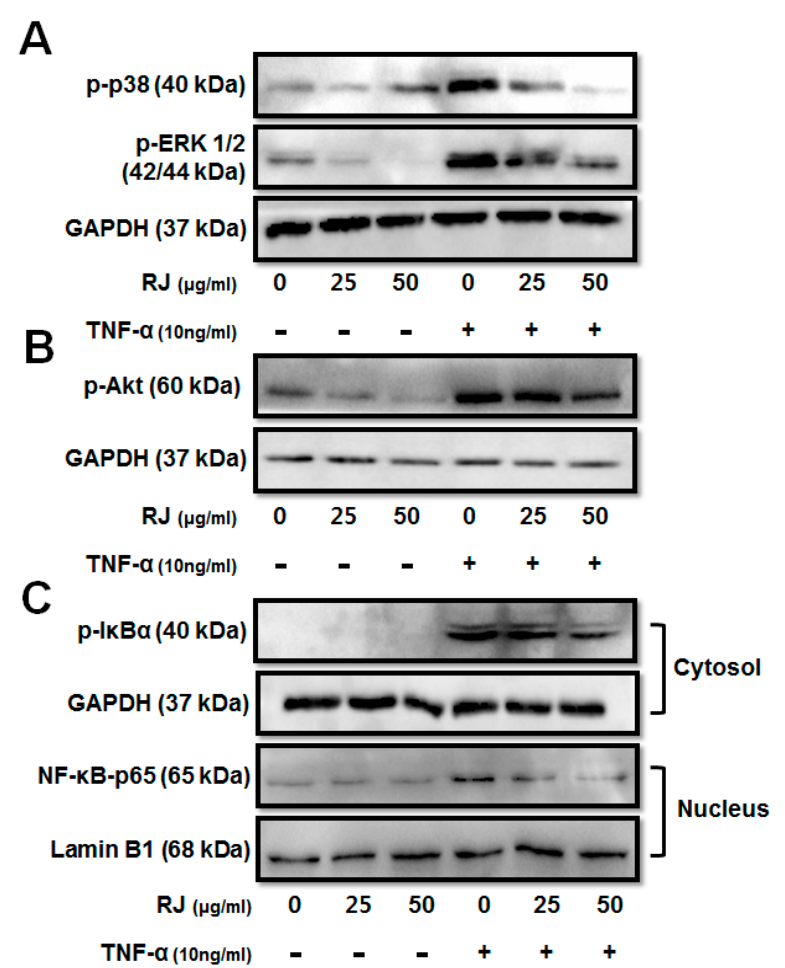
Figure 3. The inhibitory effect of RJ on TNF- α -stimulated mitogen-activated protein kinases (MAPK) and nuclear factor-kappa B pathways. HaCaT cells were pretreated with 0, 25 and 50 µ g/mL RJ for 30 min then stimulated with 10 ng/mL of TNF- α for 30 min. ( A ) MAPKs including ERK1/2, p38 were assessed by Western blot analysis. ( B ) Akt phosphorylation was inhibited in a dose-dependent manner after TNF- α stimulation of the HaCaT cells. ( C ) Inhibition of NF- κ B pathway in TNF- α stimulated HaCaT cells was assessed by Western blot analysis. The data shown are the mean ± SD of three independent experiments.